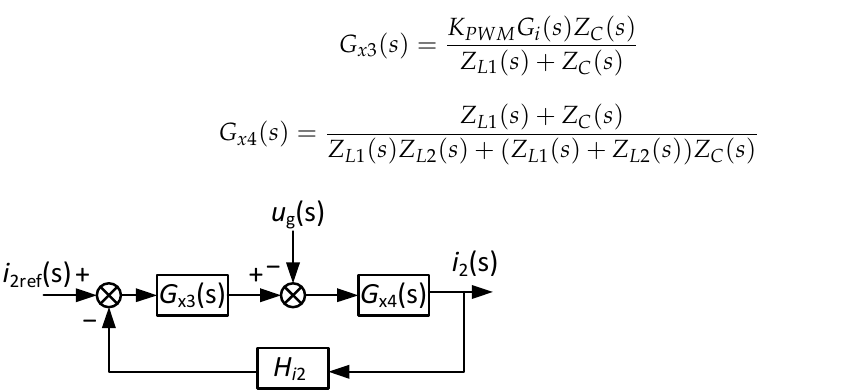
Figure 8. Control block diagram of FOGCI without capacitor current proportional feedback (Capacitor current proportional feedback was eliminated).